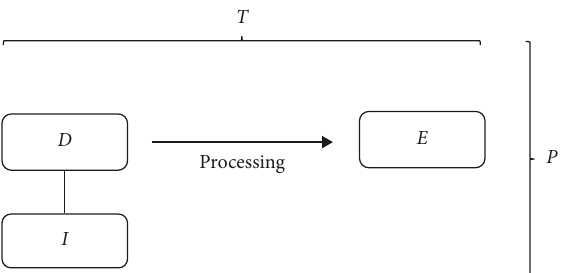
Figure 3: The basic model of the elements that constitute a workflow and the variables of the information